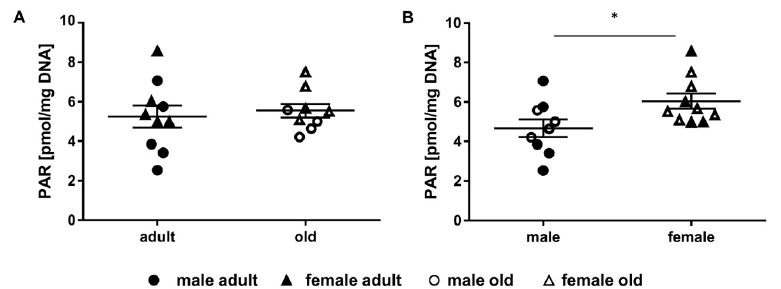
Figure 4. Impact of age and sex on PARylation. Shown are PARylation levels (individual single measurement scores per animal and group mean ± SEM) of murine liver of adult (24 weeks, n = 10) and old (109–114 weeks, n = 9) animals of both sexes (female: n = 10, male: n = 9). ( A ) adult versus old, ( B ) male versus female animals. t-test, * p ≤ 0.05.